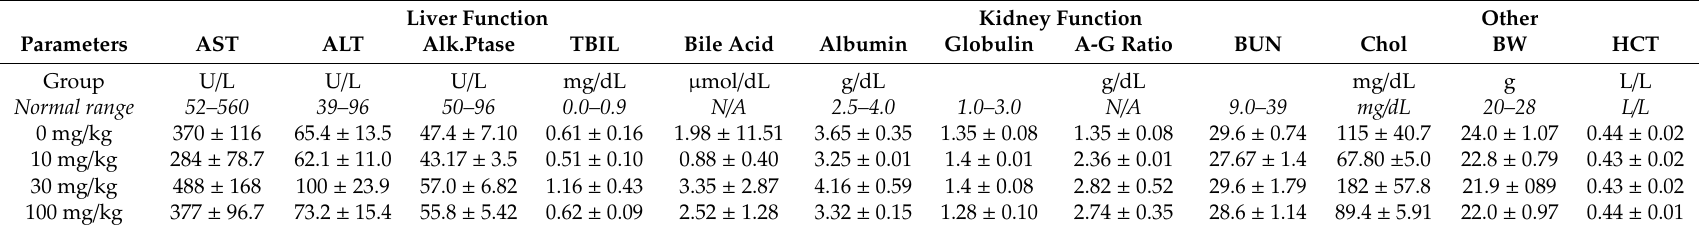
Table 2. Plasma biochemistry. Acute toxicity (athymic nude mice): plasma biochemistry.